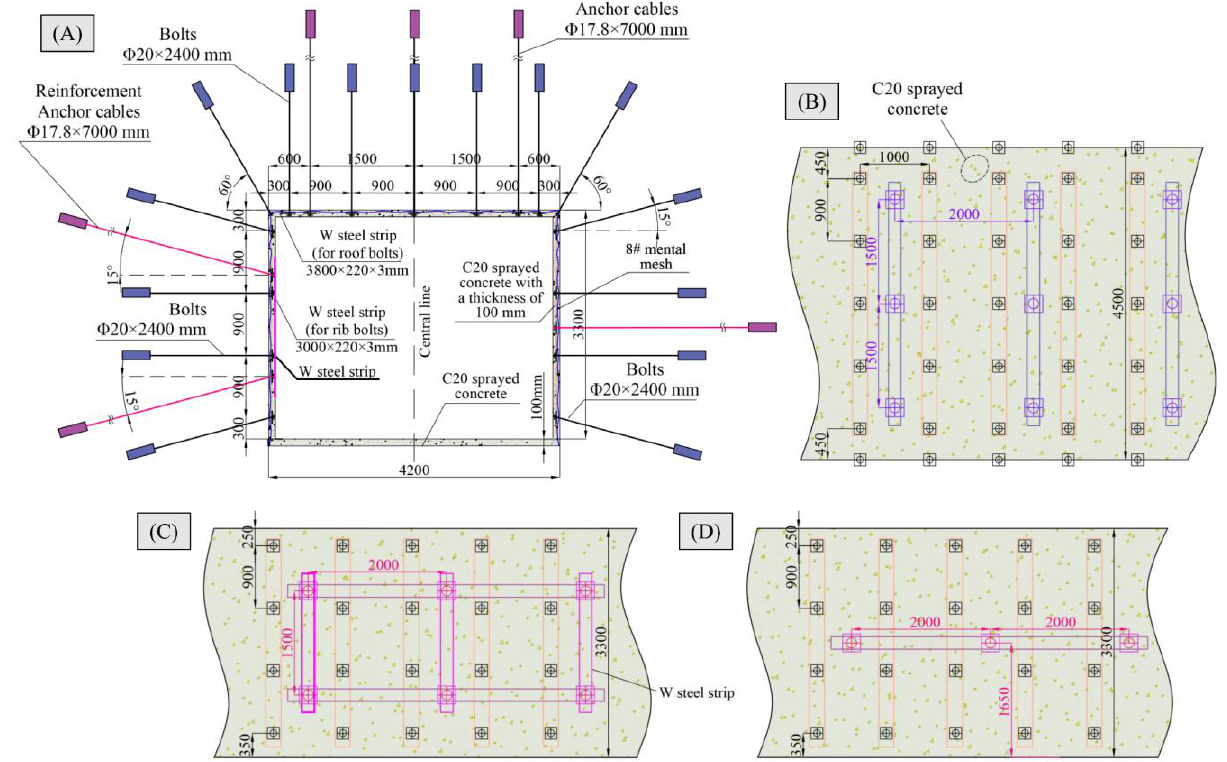
Figure 15. No. 3 coal seam main return-air roadway reinforcement support program. ( A ) Entry section. ( B ) Support pattern in roof. ( C ) Support patter in coal pillar rib. ( D ) Support pattern in